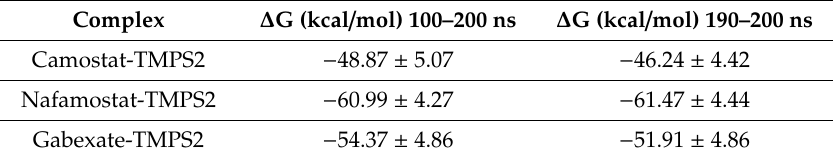
Table 5. Computational binding a ffi nity ( ∆ G) of the ligand-protein complexes.